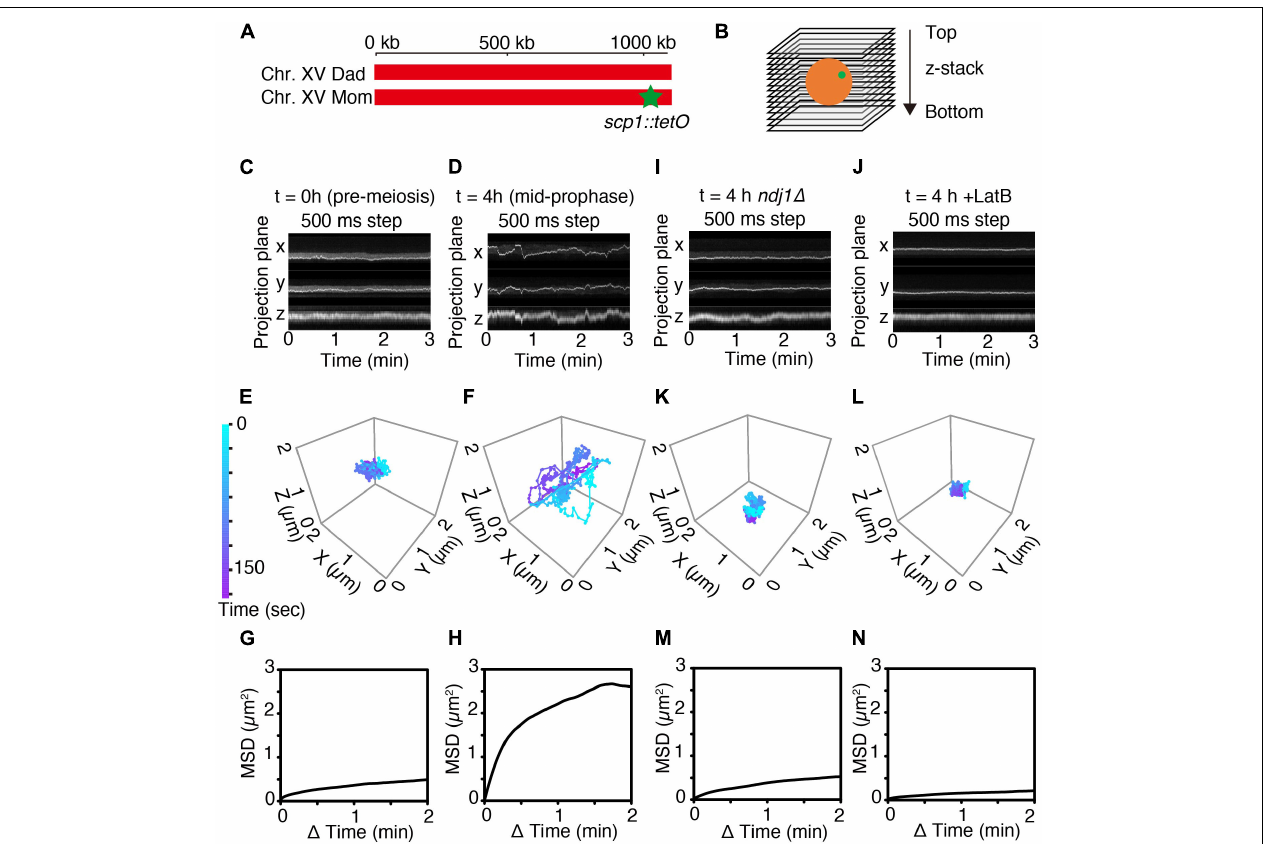
FIGURE 1 | 4D imaging of telomere trajectories. (A) Chromosome labeling of the SCP1 locus with TetR-mEGFP. The end of only one chromosome (chromosome XV) in a diploid cell is labeled. (B) The scheme of 3D live-cell imaging in budding yeast. (C,D) Kymographs of representative cells tracked in 3D at t = 0 h ( C ; pre-meiotic G1/G0) and at t = 4 h ( D ; mid-meiotic prophase) cultured in SPM. 3D images are captured once per 500 ms. (E,F) Trajectories of the fluorescent spots shown in (C,D) as tracked in 3D at pre-meiotic G1/G0 ( t = 0 h) (E) and at meiotic prophase ( t = 4 h) (F) . (G,H) MSD curves of the tagged SCP1 locus in cells at pre-meiotic G1/G0 (G; n = 10 cells) and at meiotic prophase (H; n = 17 cells). (I–N) Kymographs, representative trajectories, MSD curves for ndj1 (cid:49) mutant cell(s) ( I,K,M ; n = 10 cell) and LatB-treated cell(s) ( J,L,N ; n = 10 cells) exactly as in the corresponding (C,E,G)